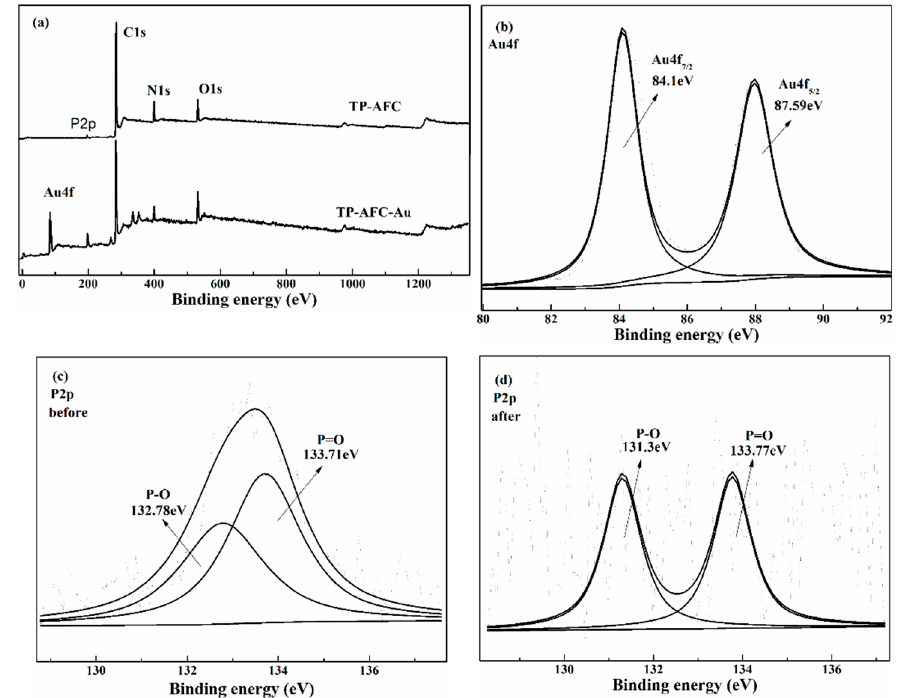
Figure 8. XPS spectra of TP-AFC before and after adsorption.